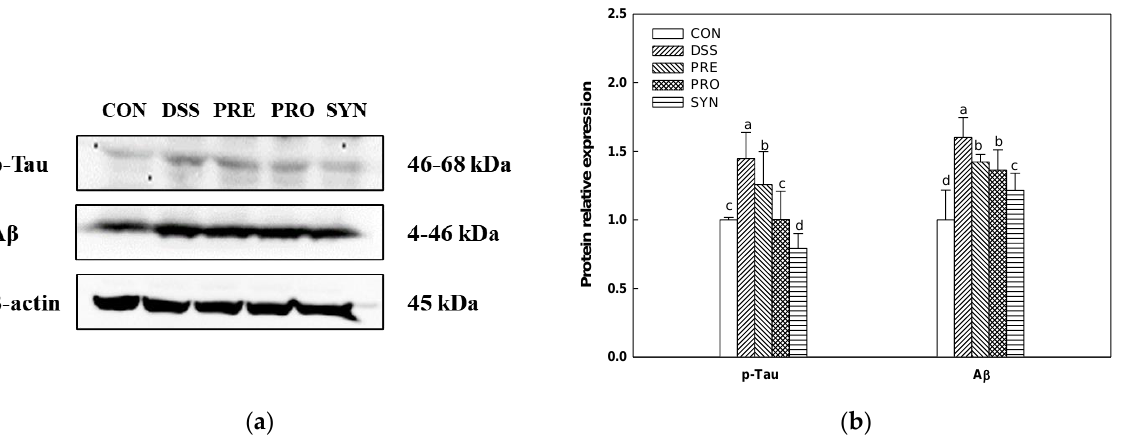
Figure 8. Effects of PRE, PRO, and SYN on cognitive impairment of DSS-induced colitis mice via inhibition of tau hyperphosphorylation and amyloid β (Aβ) production. Western blot band images ( a ), and the expression levels of p- tau and Aβ ( b ). The results were presented as the mean ± SD ( n = 3). Data were statistically considered at p < 0.05, and different lowercase letters indicate significant differences between groups.